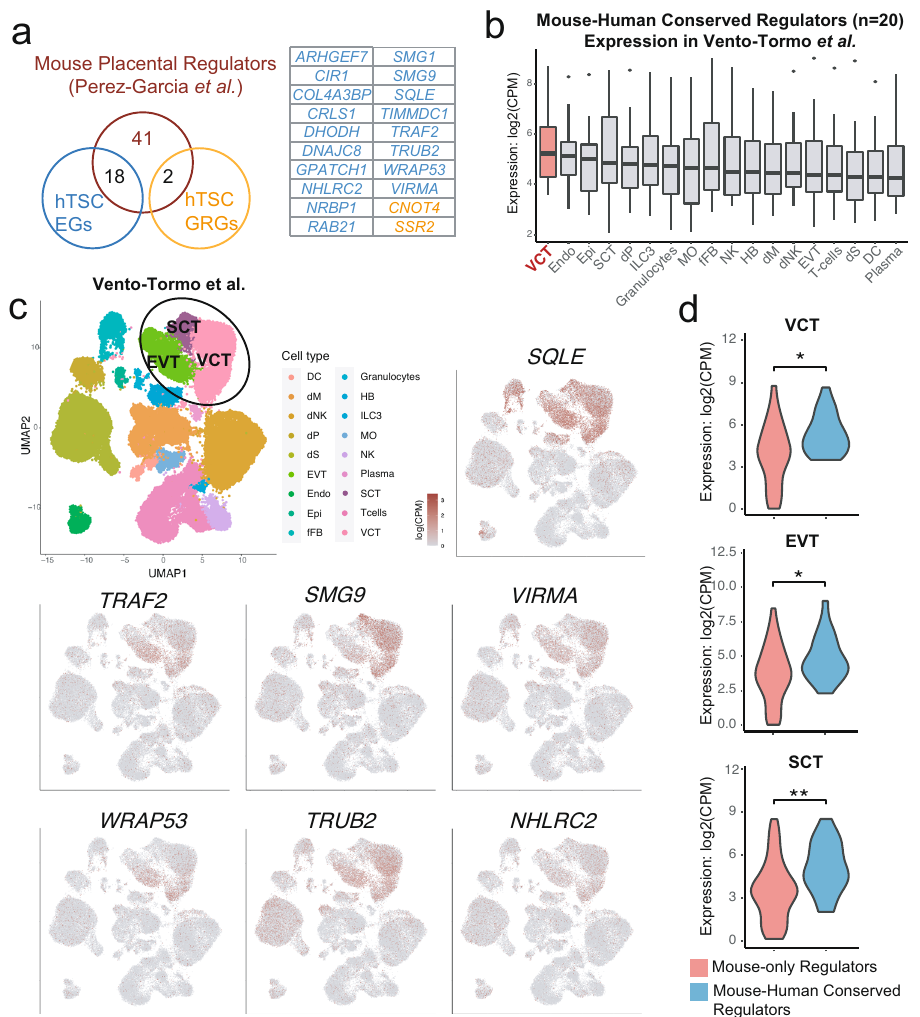
Fig. 6 Comparison of hTSC EGs and GRGs with genes required for mouse placentation. a Overlap of hTSC EGs and GRGs with a published list of embryonic lethal genes known to cause placental defects in mouse 90 . b Expression of genes that lead to mouse placentation defects and overlap with hTSC EG/GRG lists ( n = 20) in different cell types found in published human maternal-fetal interface scRNA-seq dataset 91 . Cell types were ranked based on mean gene expression. Boxplot presents the 25th, median, and 75th quartiles, the whiskers extend 1.5 of interquartile ranges, and the dots are outside values >1.5 times and <3 times the interquartile range beyond either end of the box. c Expression visualization of selected mouse-human conserved regulators (Fig. 6a) in the human maternal-fetal interface scRNA-seq dataset 91 . d Expression of genes required for mouse placentation that do not ( n = 41) and do ( n = 20) overlap with hTSC EGs and GRGs in the VCTs (CTBs), EVTs, and SCTs (STBs) of published human maternal-fetal interface scRNA-seq dataset 91 . Two-tailed Wilcoxon Rank Sum Test was used for statistical analysis. ‘ * ’ indicates a p -value < 0.05 and ‘ ** ’ indicates a p -value < 0.01. The exact p -values are 0.011 (VCT), 0.047 (EVT), and 0.0033 (SCT). VCT: 9479 cells; EVT: 3626 cells; SCT: 1261